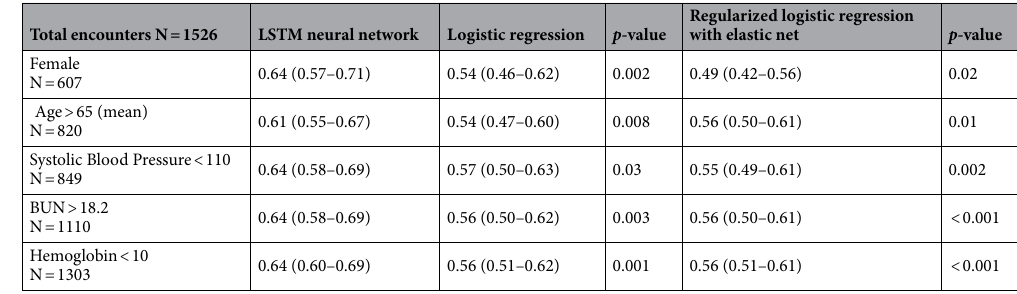
Table 5. Sensitivity Analyses for external validation eICU dataset. Systolic Blood Pressure, BUN, and hemoglobin cutoffs were derived from the Glasgow Blatchford Score. Hemoglobin cutoff was chosen due to the matched risk for both men and